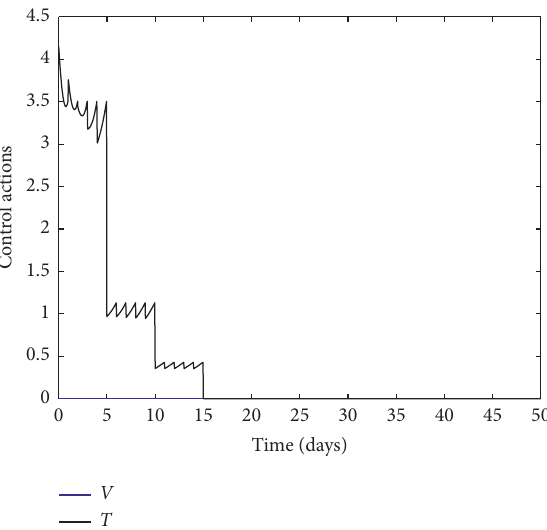
Figure 10: Control efforts for the output targeting